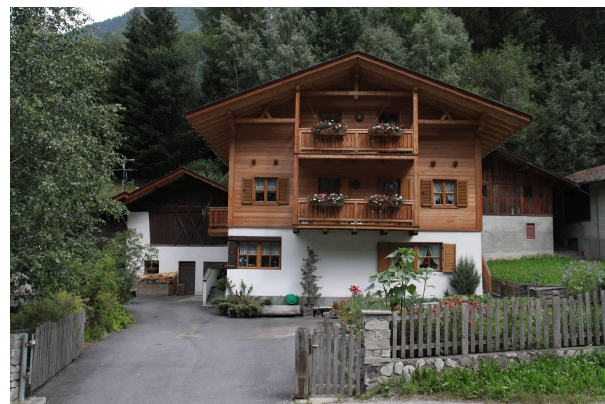
Figure 5. Traditional residential building in Gand, number 27 (Photo: Schwendtner B., 2011) 2 Fig. 5. Traditional residential building in Gand, number 27 (Photo: 3 B. Schwendtner, 2011)